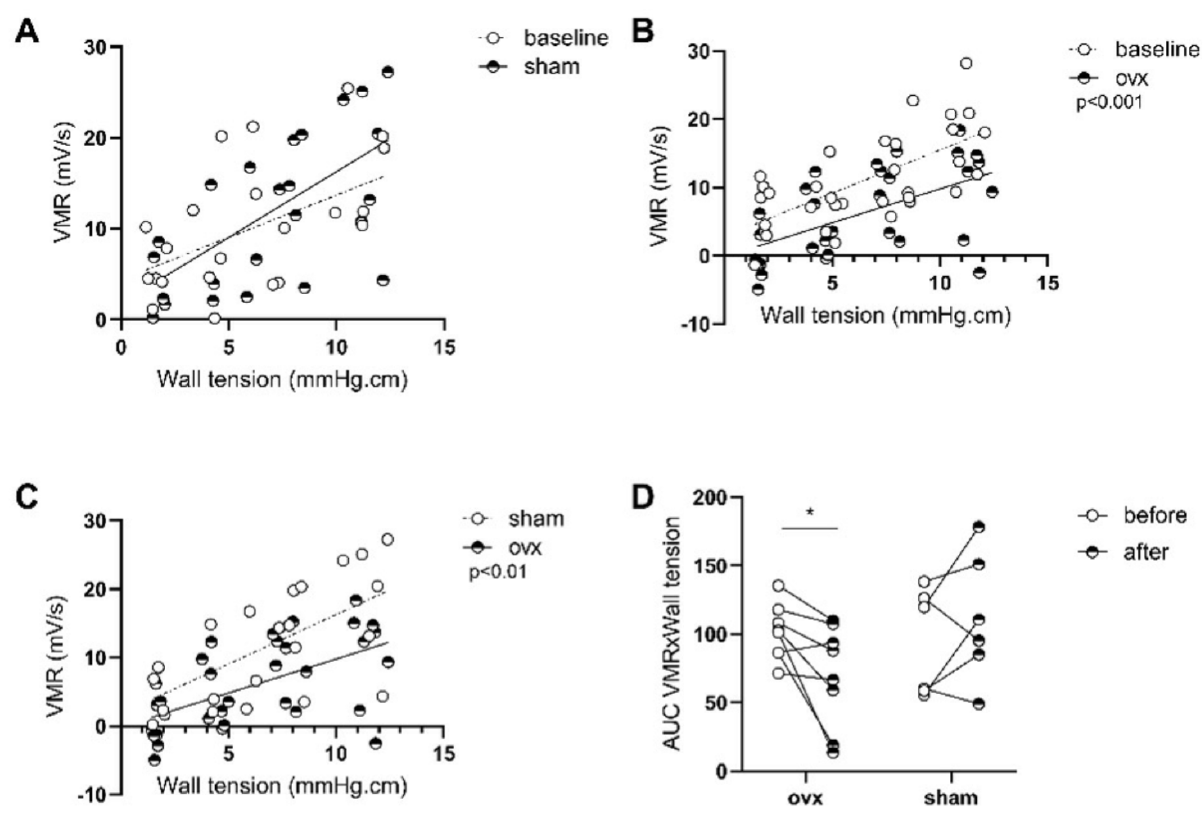
Figure 4. Effect of ovariectomy in MS females on colonic sensitivity. Colonic sensitivity was assessed by testing the elevation of linear regression curves using a Fisher test between MS female at baseline and 15 days after sham operation ( n = 6) ( A ), between MS females at baseline and after ovariectomy ( n = 8) ( B ), and between MS female after sham operation and MS female after ovariectomy ( C ). Individual representation of the effect of the ovariectomy ( D ), tested with a two-way ANOVA comparing paired time point. Data are presented as mean ± SEM ( A ). * p < 0.05. MS—maternal separa-